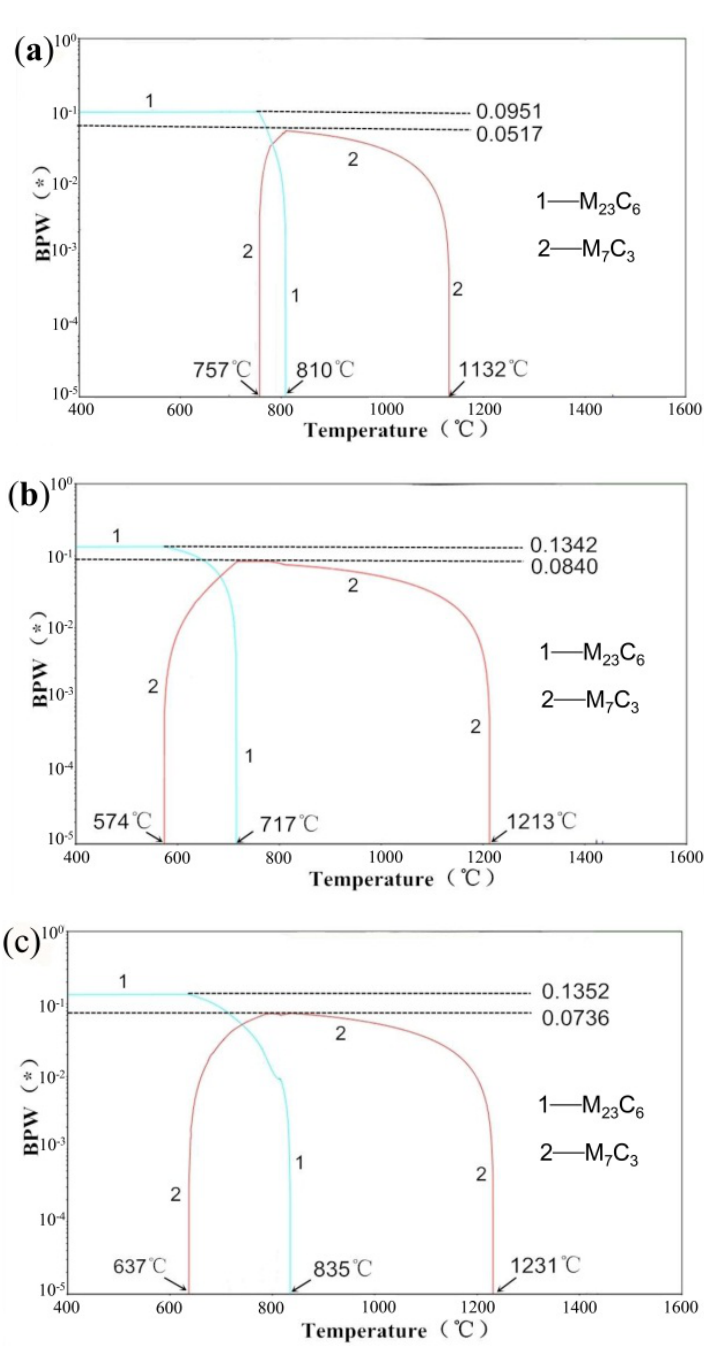
Figure 5. Type and content of carbide in different surfacing layers. ( a ) 5Cr13; ( b ) 8Cr13; ( c ) 8Cr13MoV.